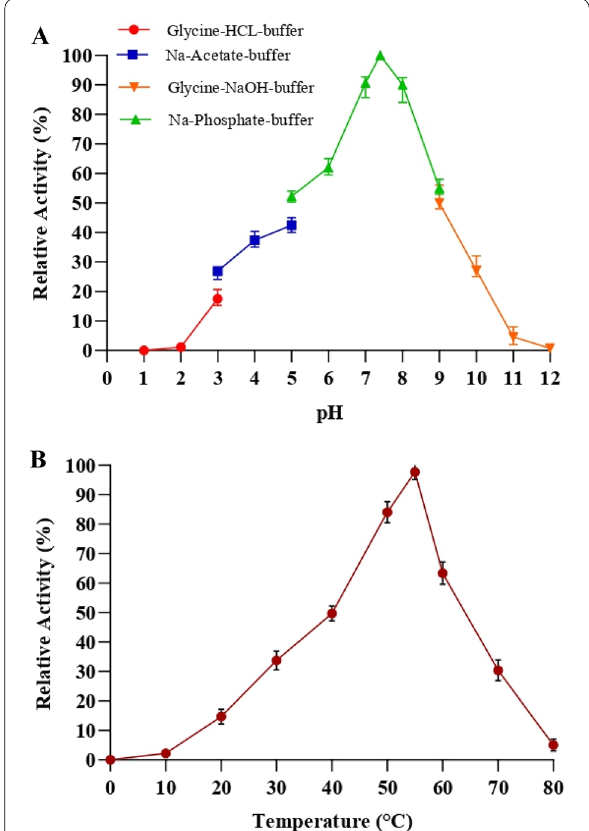
Fig. 2 Biochemical profiling of opdH enzyme of Arthrobacter sp. HM01, A pH profiling of opdH enzyme, B temperature profiling of opdH